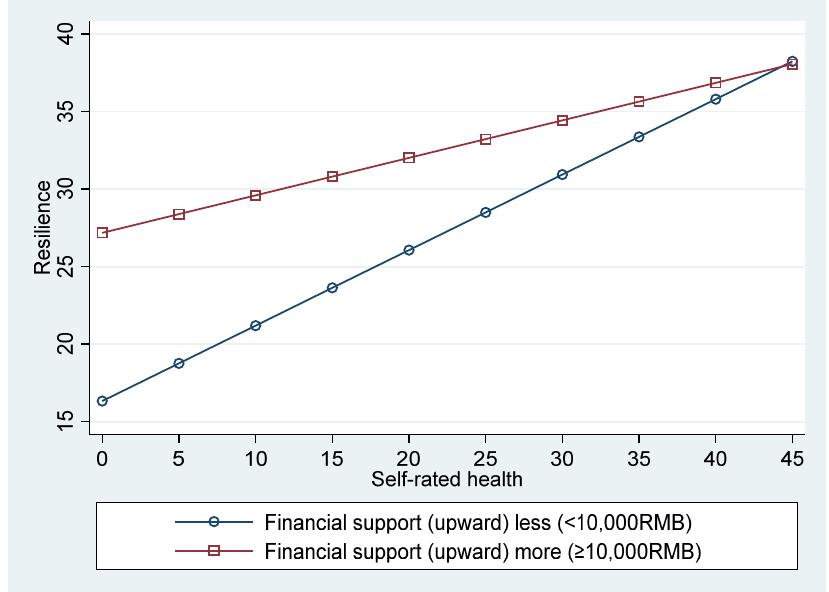
Figure 2. Emotional support moderated the effect of self-rated health on resilience.